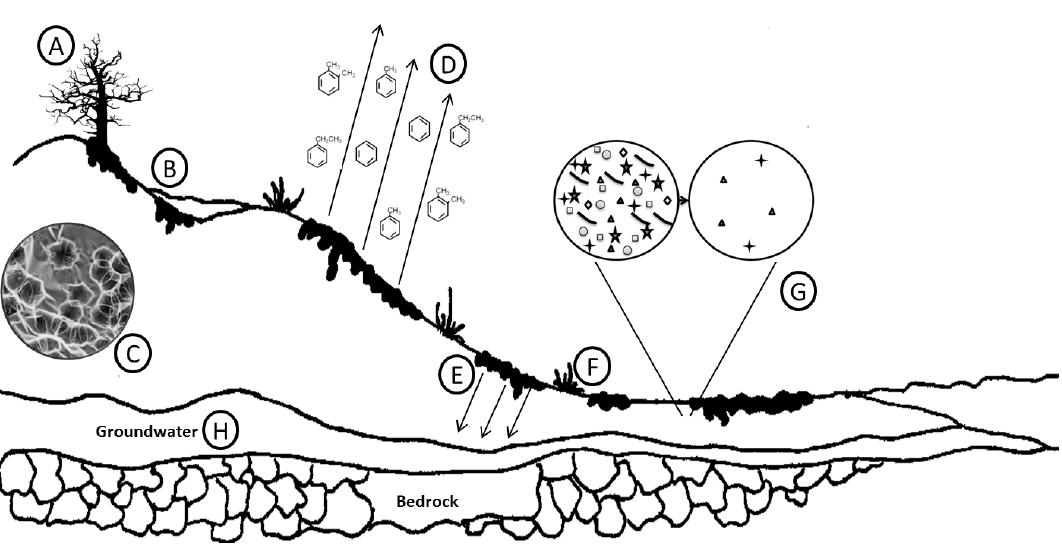
Figure 1. Fate of oil and site characteristic changes following a terrestrial oil spill event: ( A ) Plant death, ( B ) anaerobic zones, ( C ) altered soil structure, ( D ) volatilization, ( E ) hydrocarbon percolation, ( F ) aerobic zones, ( G ) initial decrease in microbial populations and diversity, ( H ) hydrocarbon contaminated groundwater.